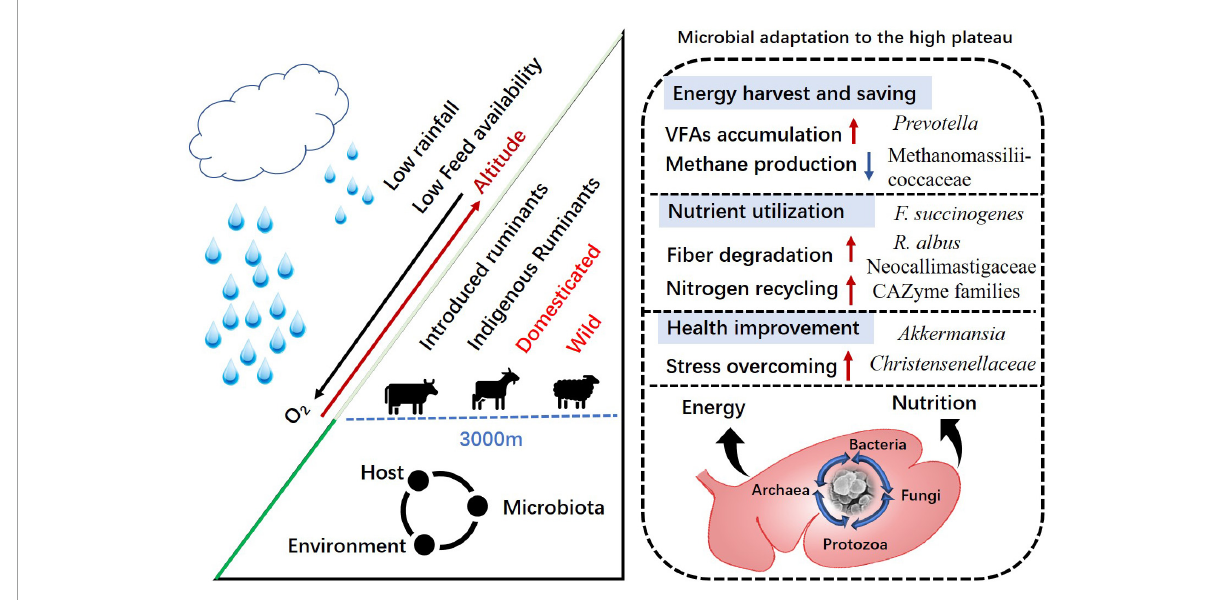
FIGURE1 Rumen microbial adaptation to the Qinghai–Tibetan plateau among indigenous and introduced